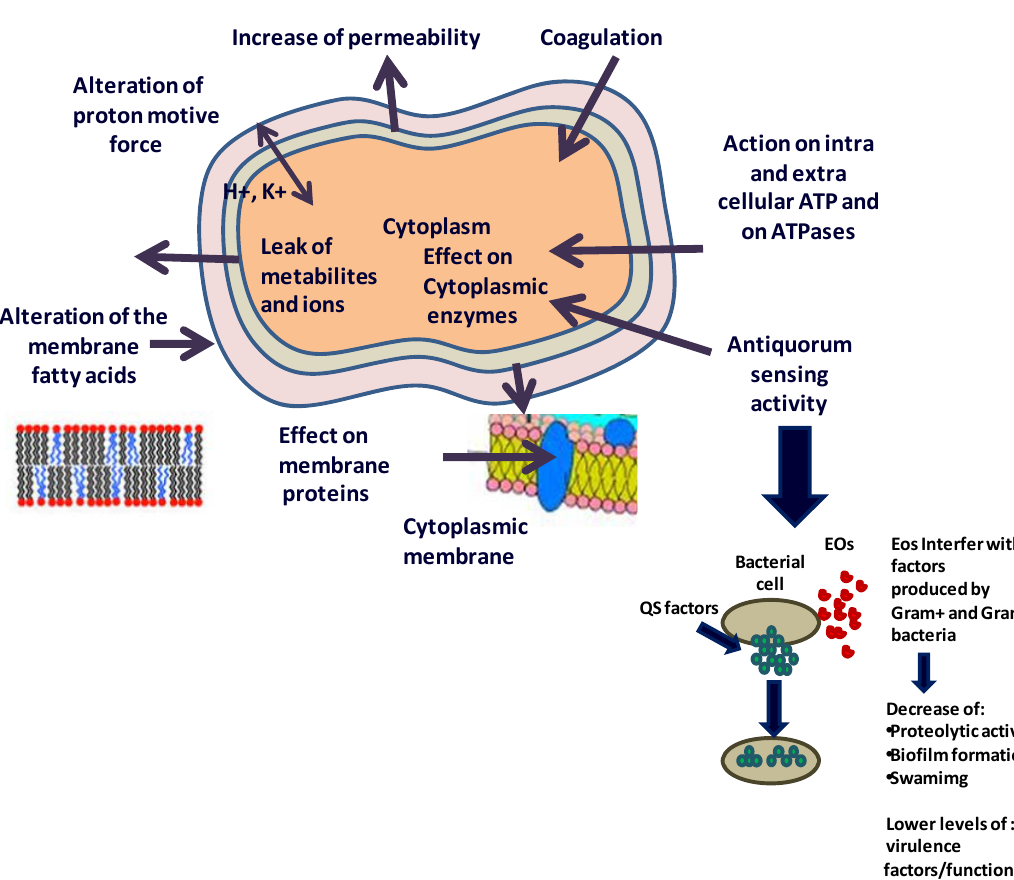
Figure 2. Mechanism of action and target sites of the essential oils on microbial